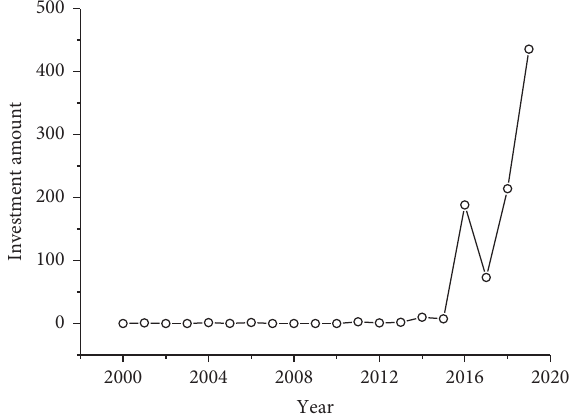
Figure 3: The annual amount of the industry